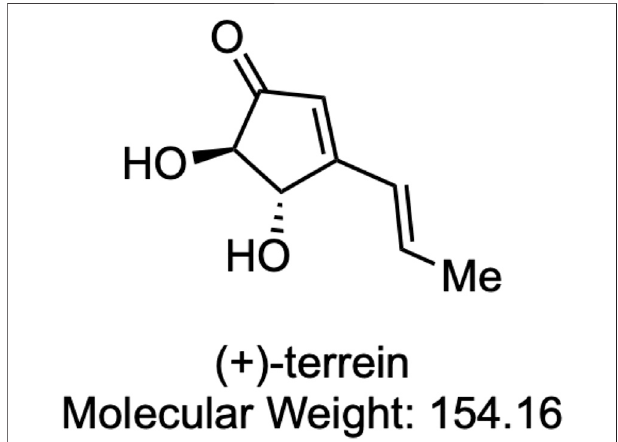
FIGURE 1 | Chemical structure of (+)-terrein. Me: